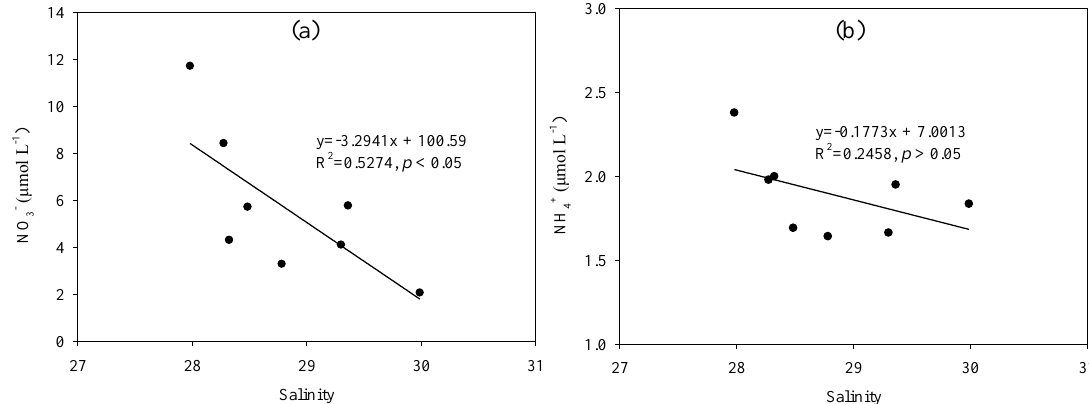
Figure 6. Linear relationship of NO 3− -salinity ( a ) and NH 4+ -salinity ( b ) in the nearshore area during the fall. Table 2. The values of δ 15 N-NO 3− and δ 18 O-NO 3− values for potential sources of nitrate in the nearshore area. δ 15 N-NO 3− δ 18 O-NO 3−